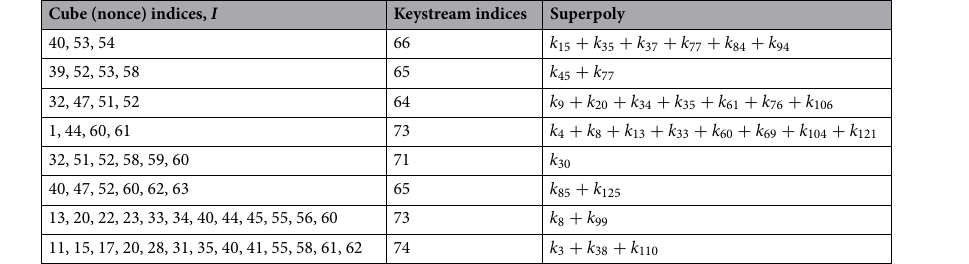
Table 5. Examples of superpolies found using KRA1.